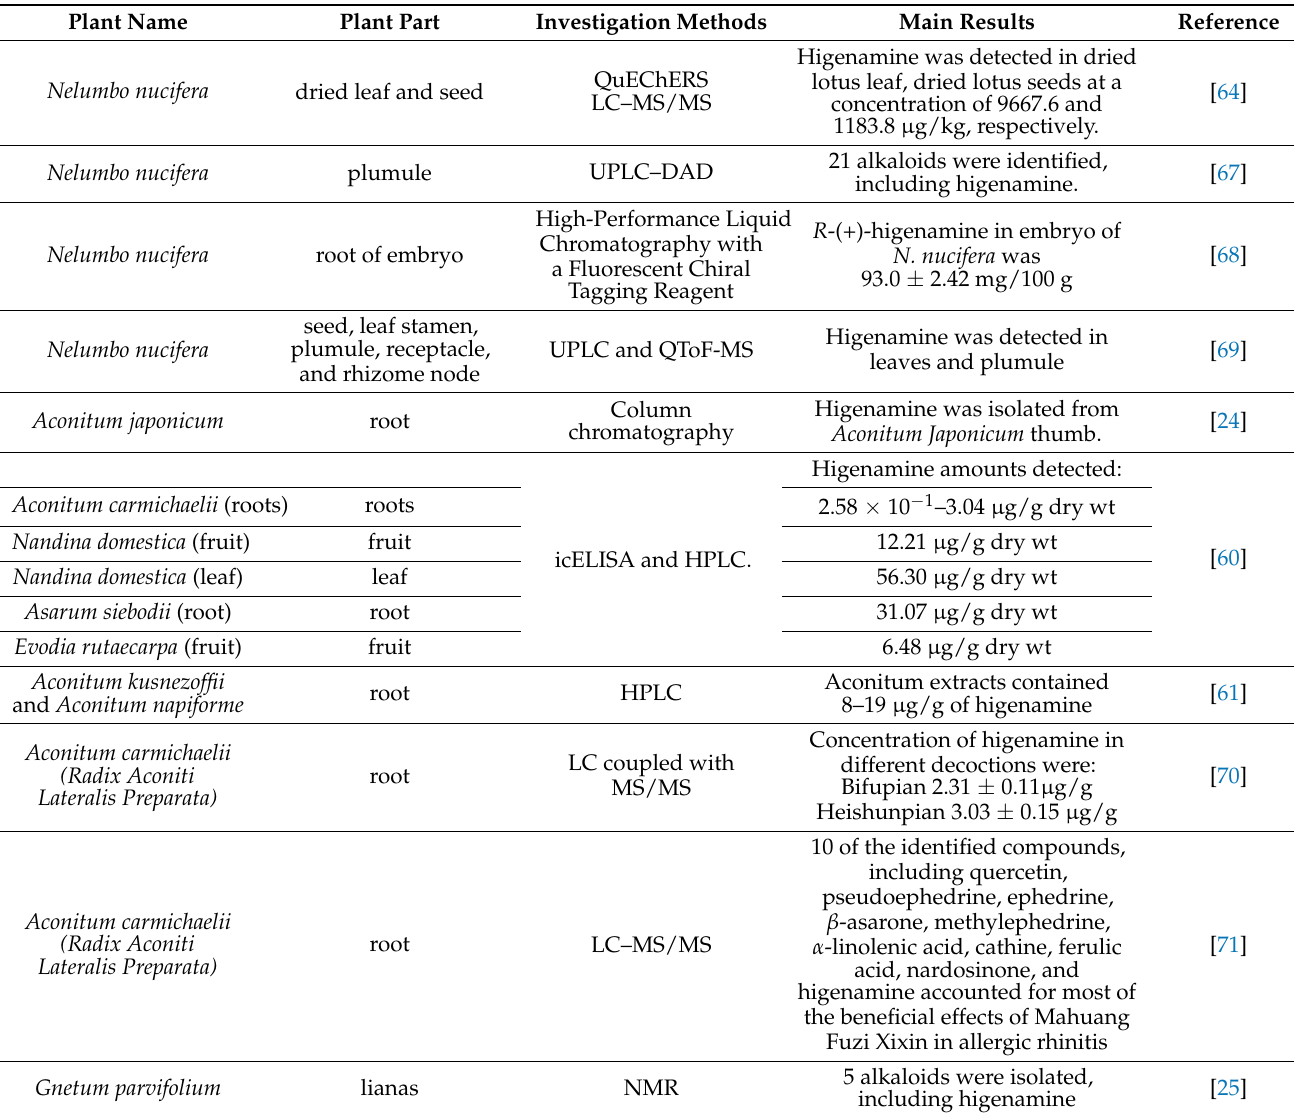
Table 1. Methods for identification and quantification of higenamine in plant